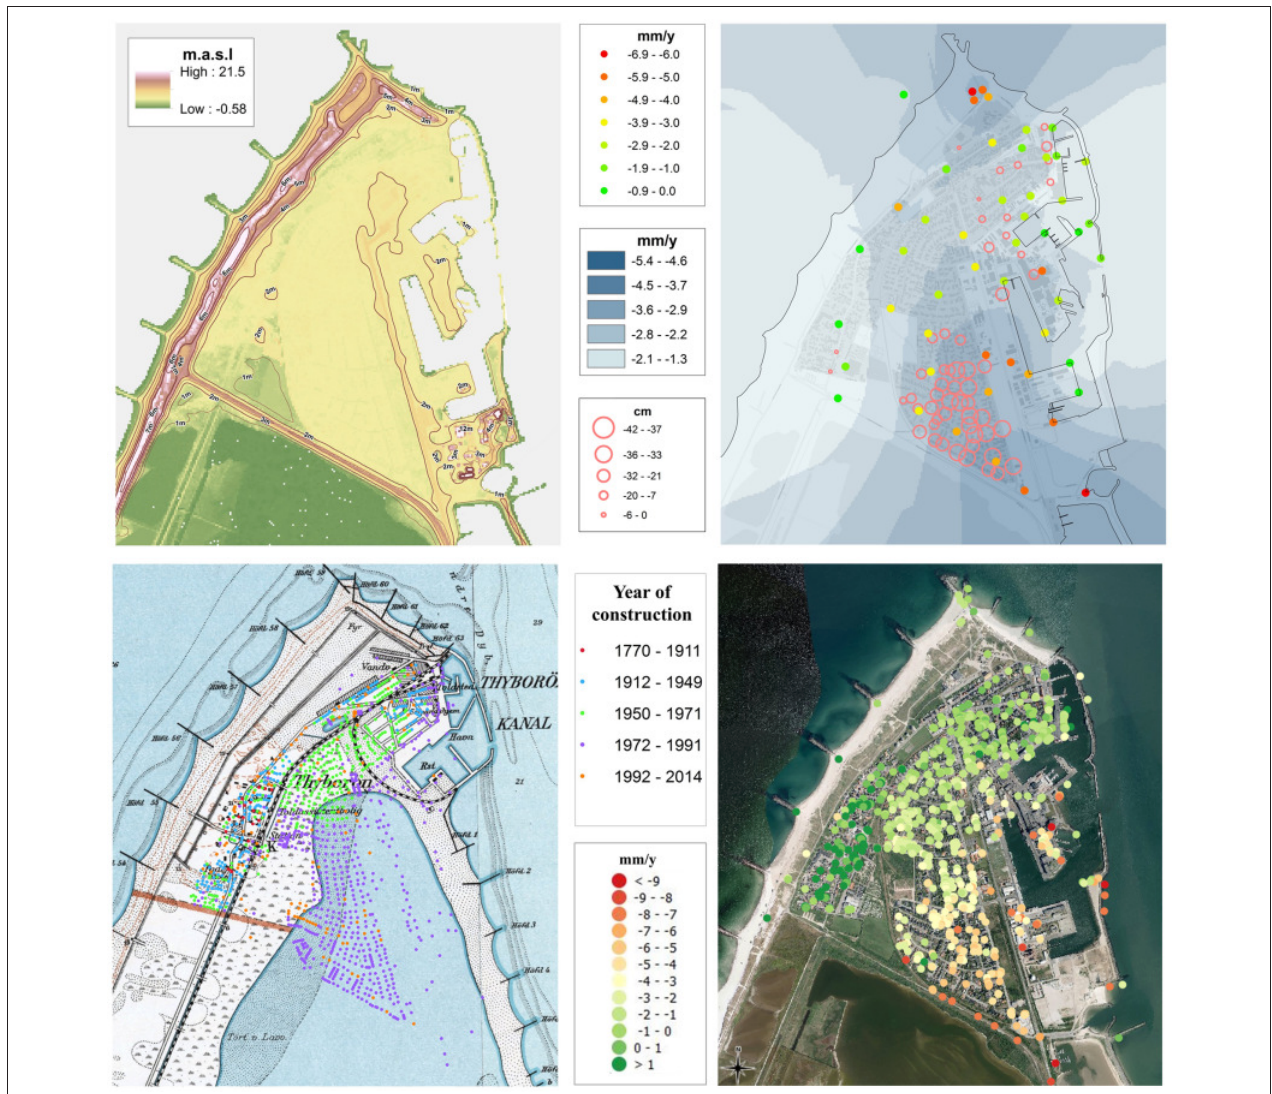
FIGURE 6 | The DTM of Thyboron shows the high dikes and dunes toward the North Sea. Also, the road into Thyboron is elevated above the general land surface of the town at or below 2.0m (top left). Repeated leveling of benchmarks (colored dots) show subsidence rates of 1–7 mm/year (2006–2015) and from ordinary kriging a small area toward N and a large area toward S experience large subsidence rates, whereas areas toward SW and N are relatively more stable. Also, the total change (1980/1990–2012) of the bottom of sewers (circles) shown a pattern that seems to closely resemble that from leveling (top right). A spatial-temporal analysis of constructions years (bottom left) shows that most houses built after 1971 (blue dots) are located on a former part of the fjord (map from c. 1930). PSI-results show the same pattern of subsidence where the SW part of town is stable and rates of subsidence are increasing from N toward SE with rates of up to 9 mm/year (1995–2001).